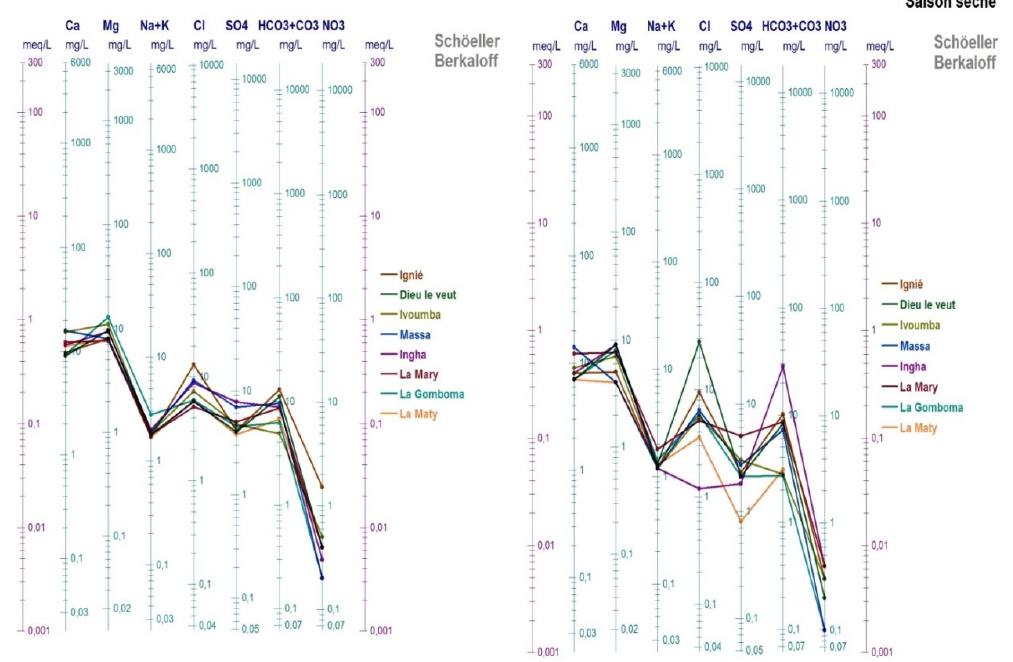
Figure 6. Diagramme de SchöellerBerkaloff entre les 2 grandes saisons.